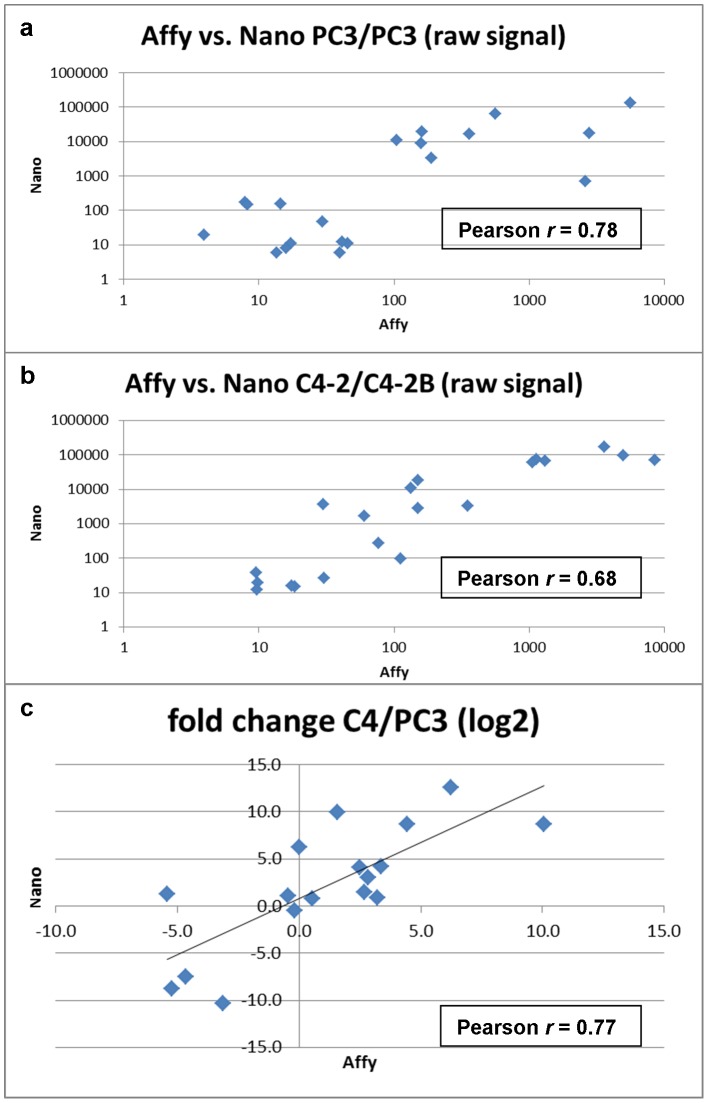
Correspondence between nCounter and DNA microarray analysis.Comparison of the raw signal values obtained for (a) PC3 and (b) C4-2/C4-2B cells are shown. The bottom panel (c) shows the comparison of fold-change calculated from the obtained data values.